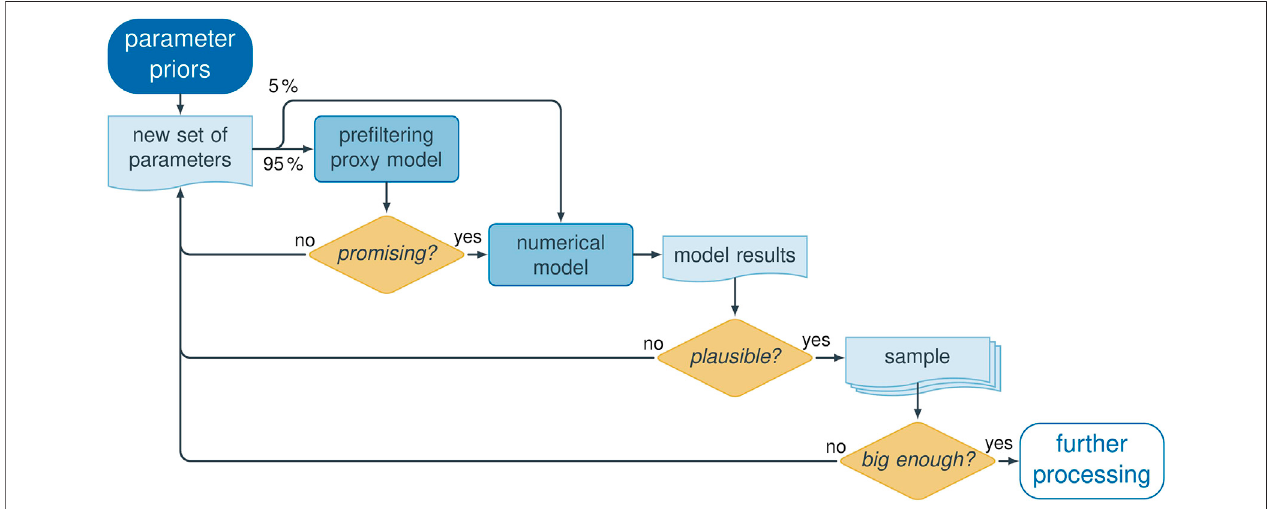
FIGURE 1 | Procedure used to generate a sample of physically plausible model realizations for the optimal experimental design analysis.